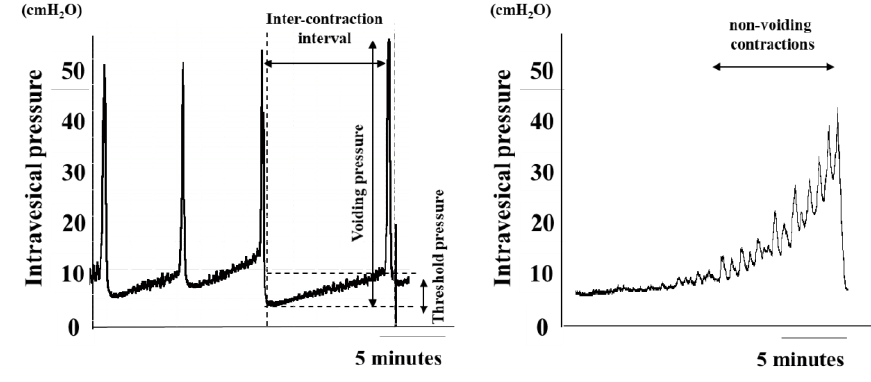
Figure 1. Cystometry parameters. Typical cystometric chart in rats. [10].